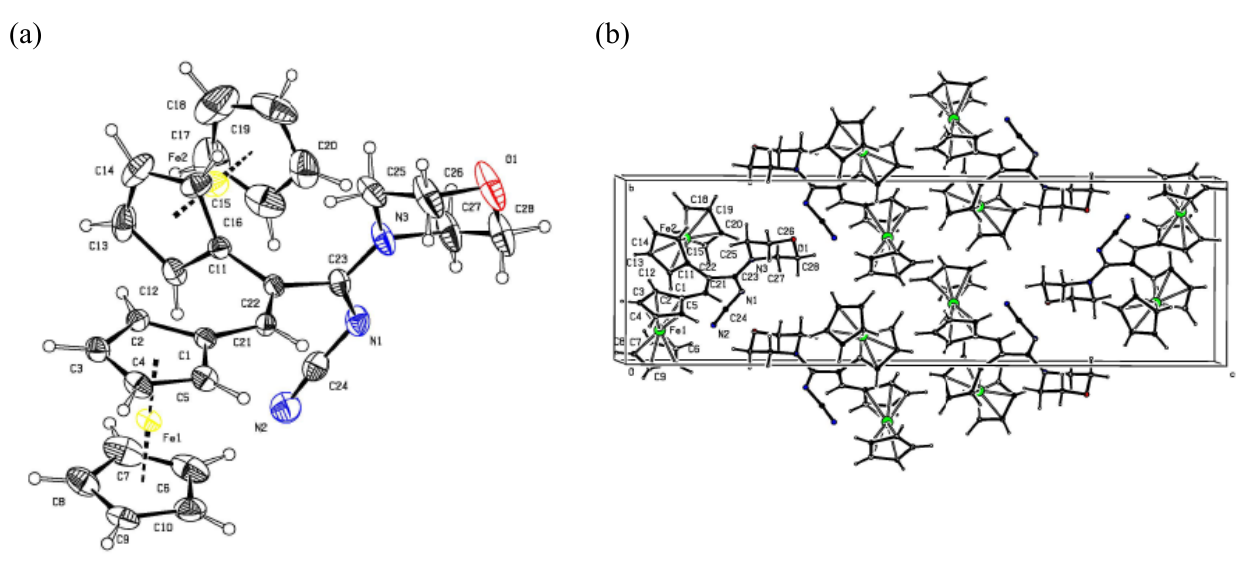
Figure 2. (a) Crystal structure of 7a ; (b) Crystal packing of 7a